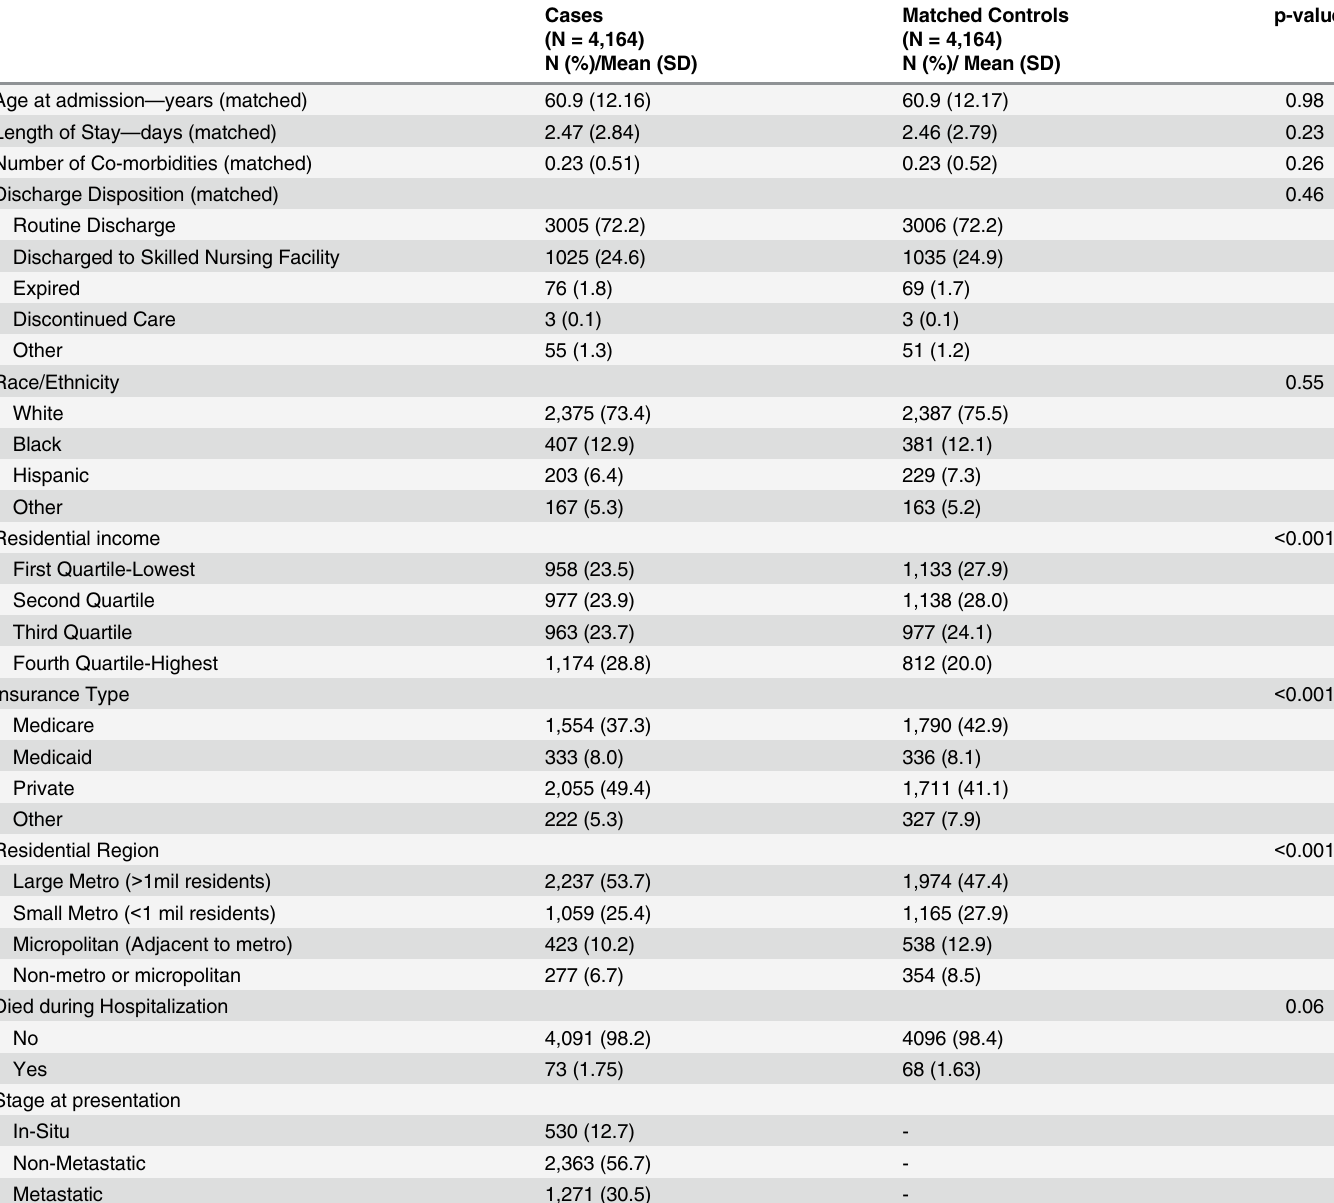
Table 1. Demographic and Patient Characteristics comparing Breast Cancer Cases and Matched Controls, Nationwide Inpatient Sample, 2006 – 2009 * +